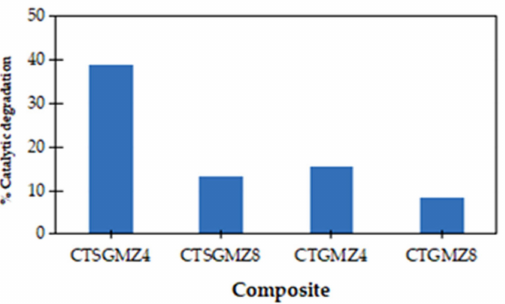
Figure 22. Dark degradation reaction of BPMC pesticide through oxidation reaction by H 2 O 2 with catalyst of ZnCr 2 O 4